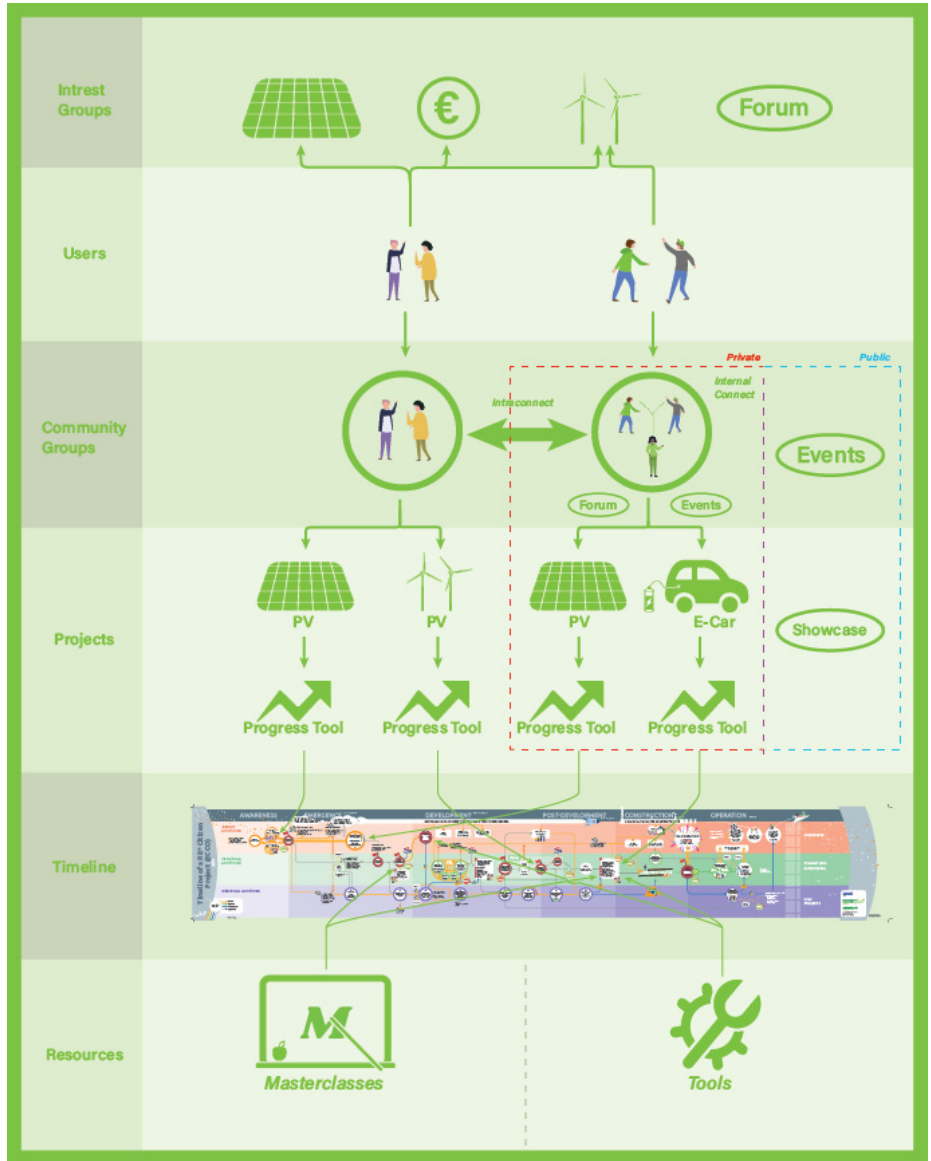
Figure 4. OSS operation overview from an energy community perspective.